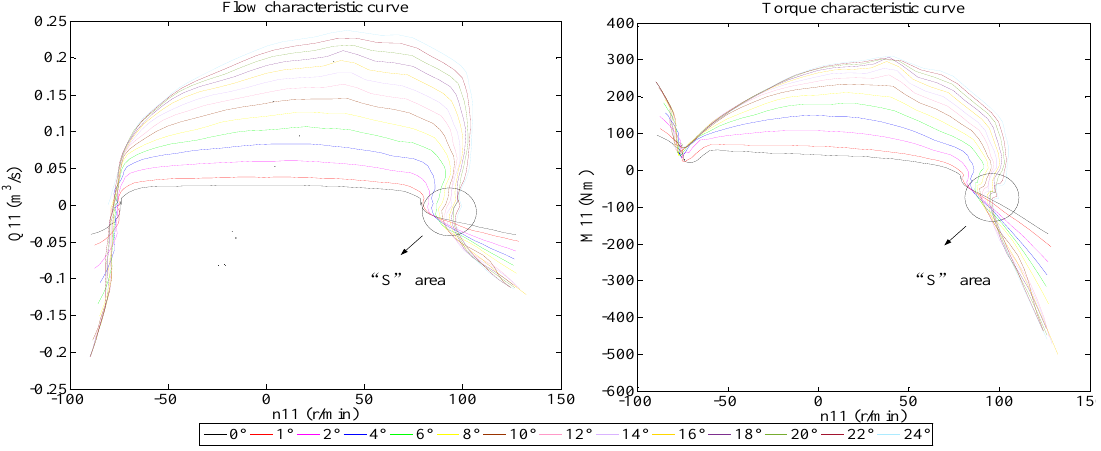
Figure 7. The characteristic curves of pump turbine.